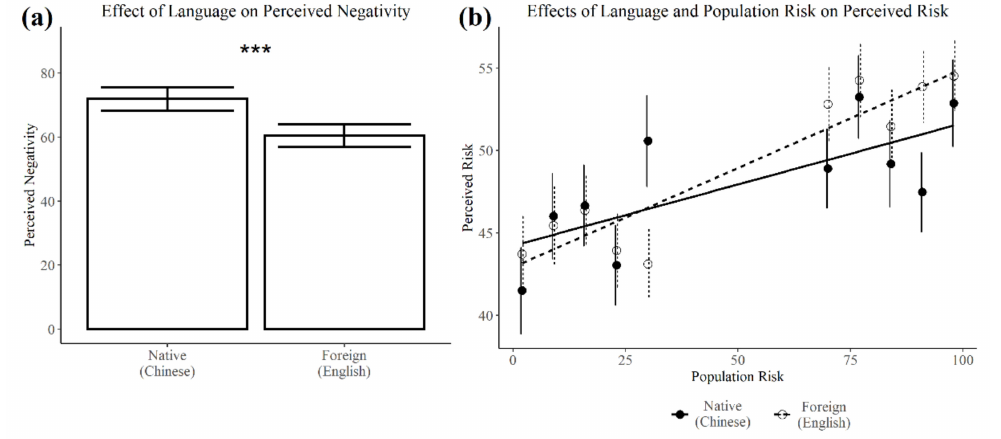
Figure 1. Effects of language on perceived negativity and perceived risk. Using a foreign language ( a ) attenuated the perceived negativity of aversive outcomes and ( b ) increased sensitivity to population risks when estimating personal risks. Error bars represent standard error. *** p < 0.001. Finding 2: Using a foreign language increases sensitivity to known population risks when